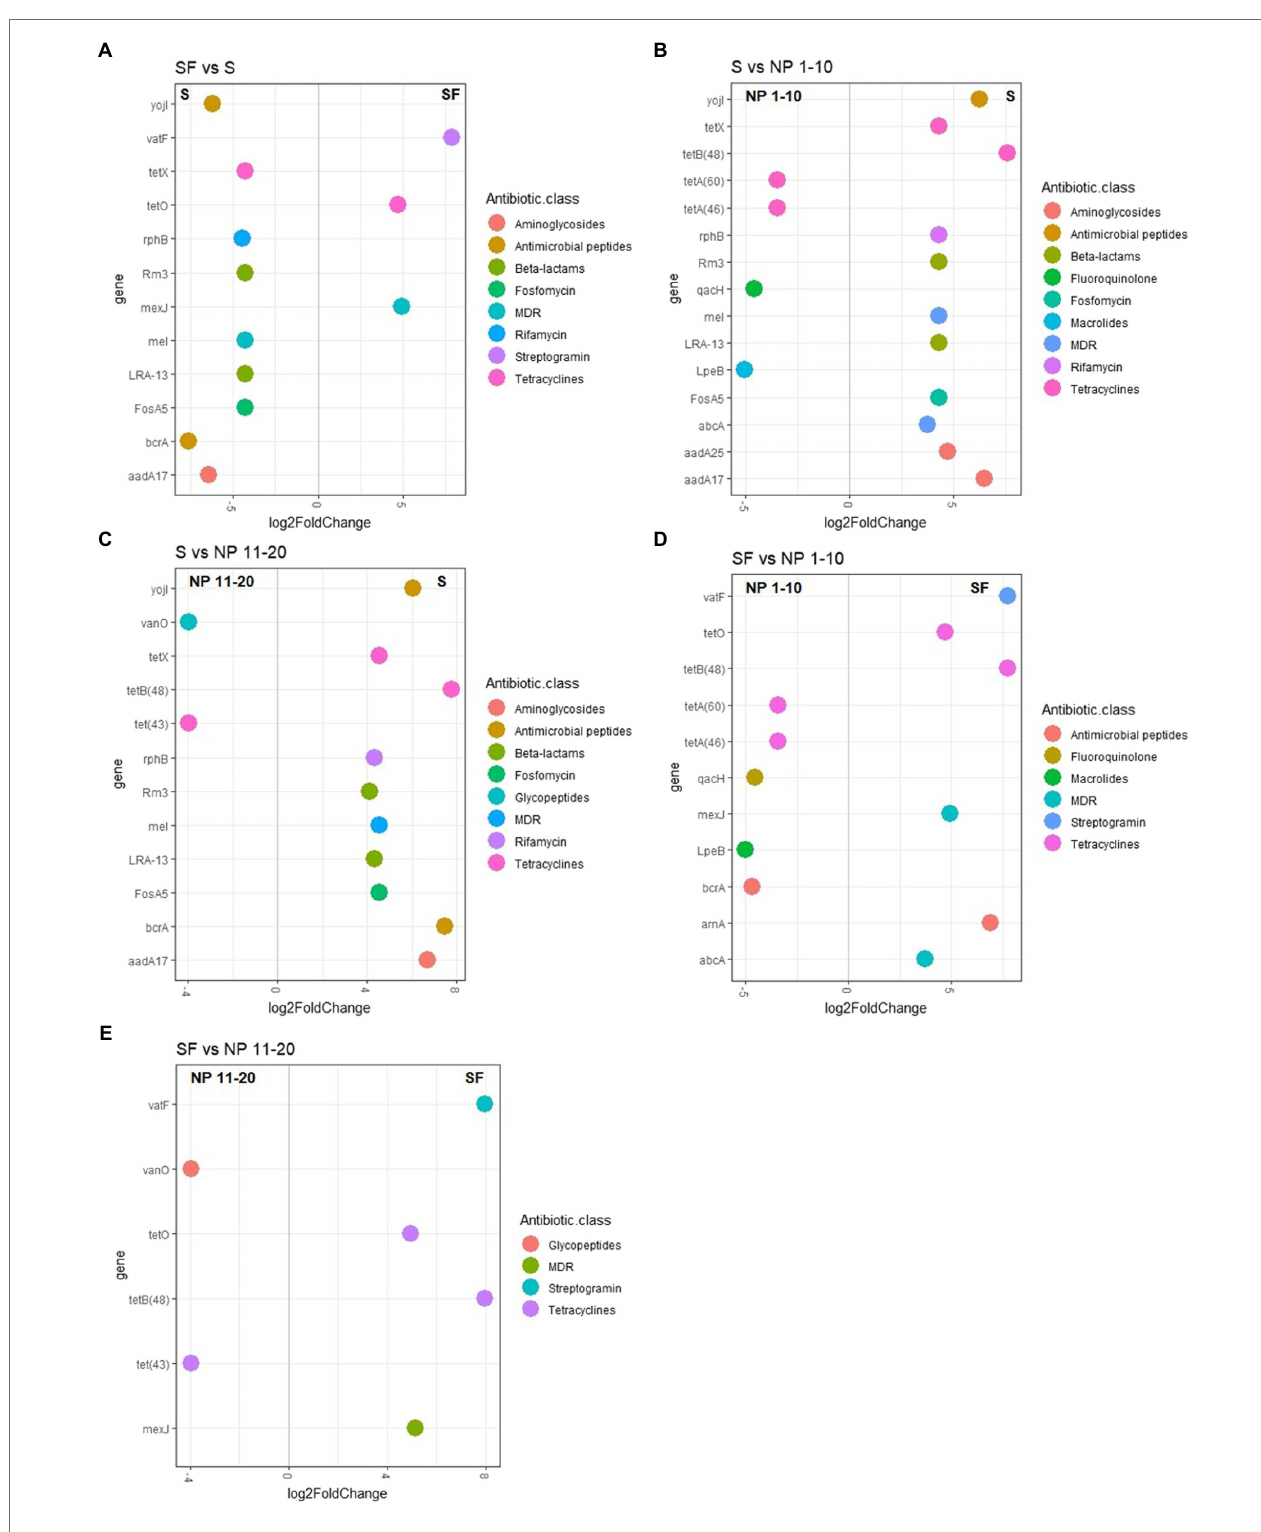
FIGURE 5 | ARG abundance pairwise comparisons between sites that showed no significant difference in vegetation levels. (A) SF versus S; (B) S versus NP 1–10; (C) S versus NP 11–20; (D) SF versus NP 1–10; (E) SF versus NP 11–20. NP 1–10: open spaces from the unaffected catchment. NP 11–20: forested area from the unaffected catchment. S: paths from the catchment with human transit. SF: forest areas from the catchment with human transit. Only results with a log2FoldChange ± 2 and an adjusted value of p lower than 0.001 are shown. n =